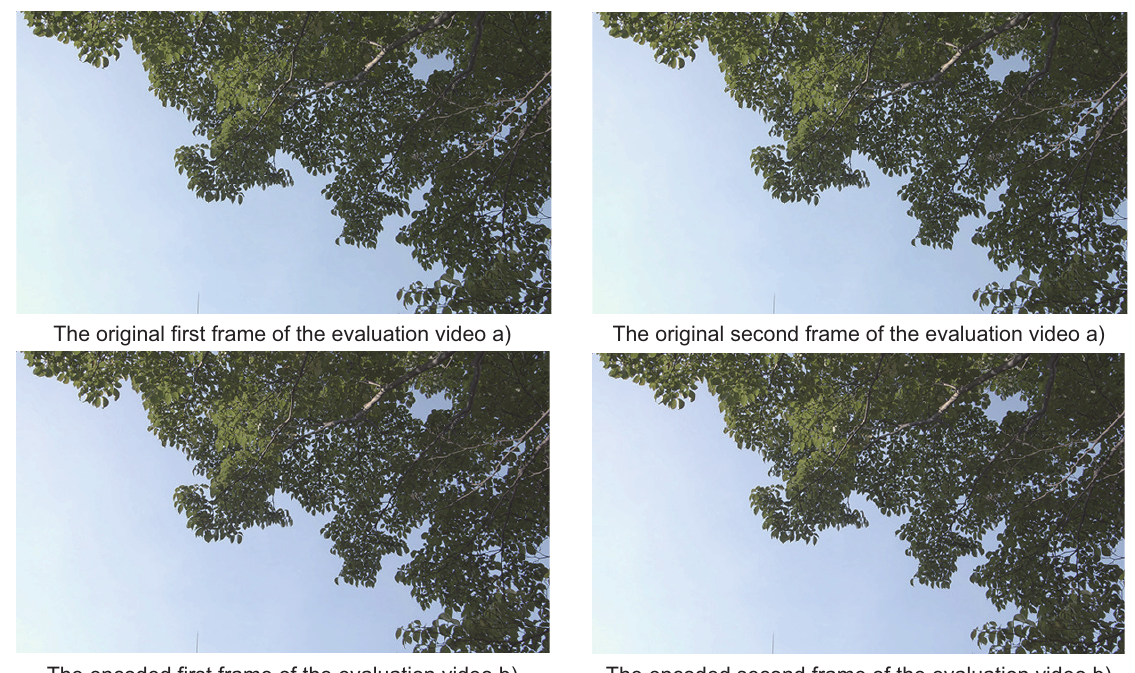
Figure 13. The first and the second frames encoded by the